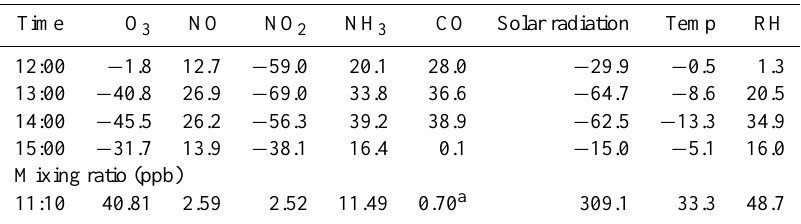
Table 2. Percentage changes in surface O 3 , NO, NO 2 , NH 3 , CO, solar radiation, ambient temperature and RH in compared with the mixing ratios just before the solar eclipse event at Thiruvanthapuram, India.